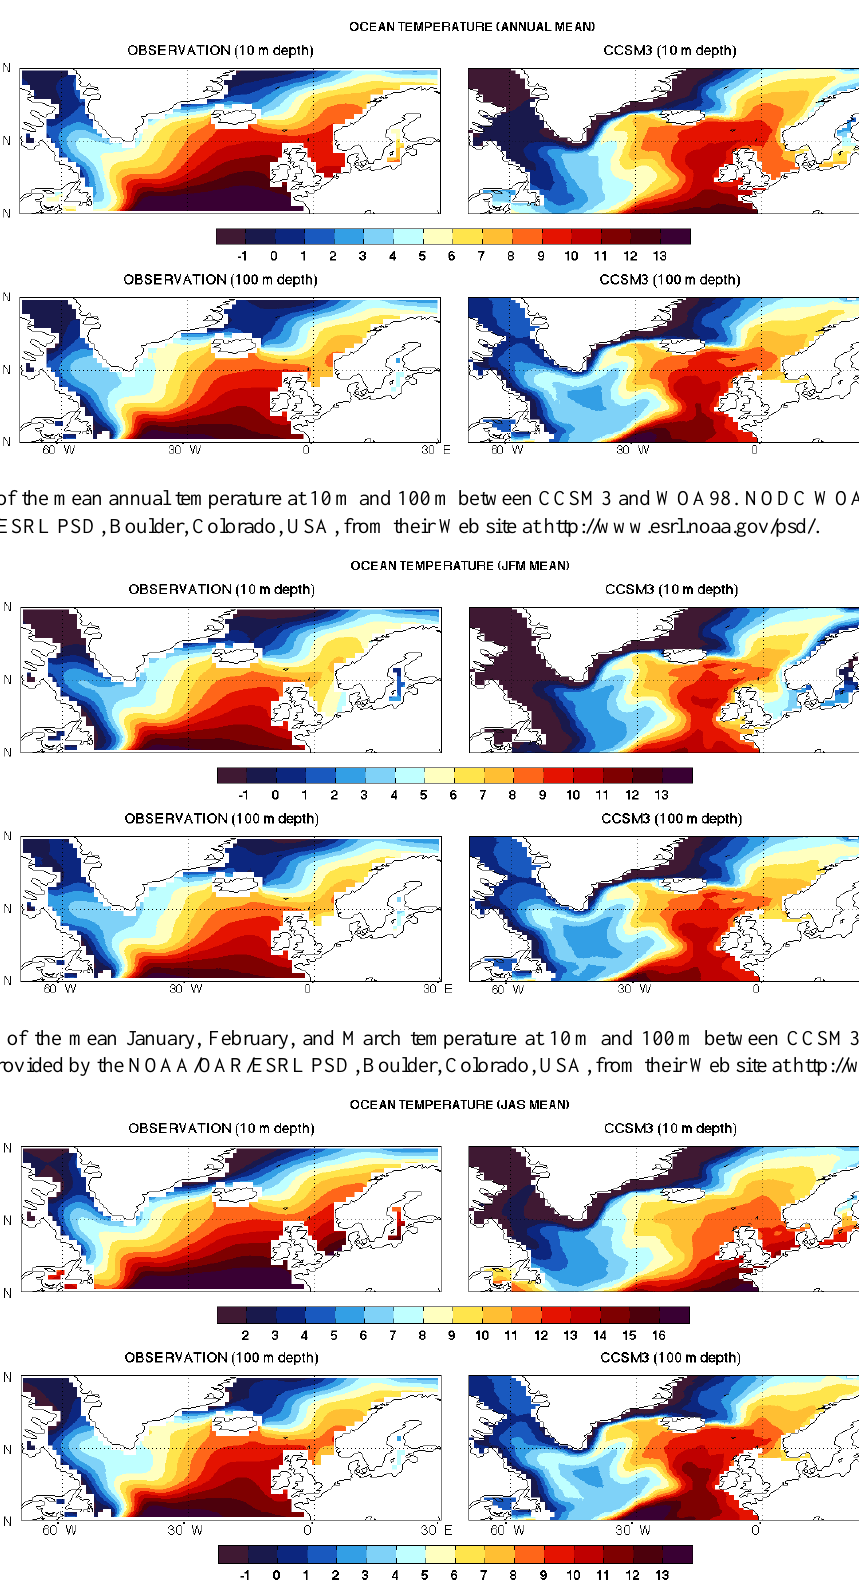
Fig. 5. Comparison of the mean July, August, and September temperature at 10m and 100m between CCSM3 and WOA98. NODC WOA98 data were provided by the NOAA/OAR/ESRL PSD, Boulder, Colorado, USA, from their Web site at http://www.esrl.noaa.gov/psd/. Clim. Past, 6, 179–193,